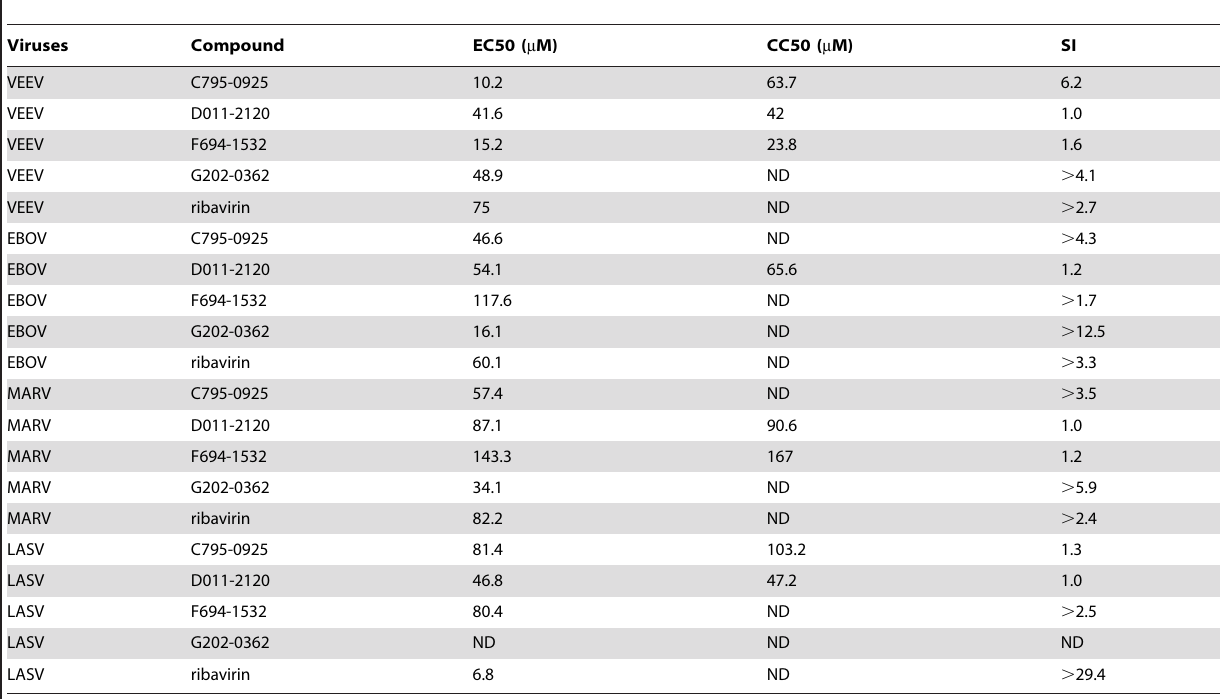
Table 2. Antiviral activity of the four hit compounds and reference compounds against VEEV, EBOV, MARV and LASV infected HeLa